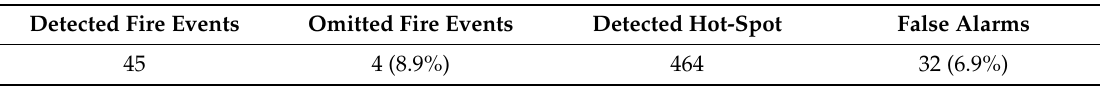
Table 2. SFIDE omission/commission matrix.